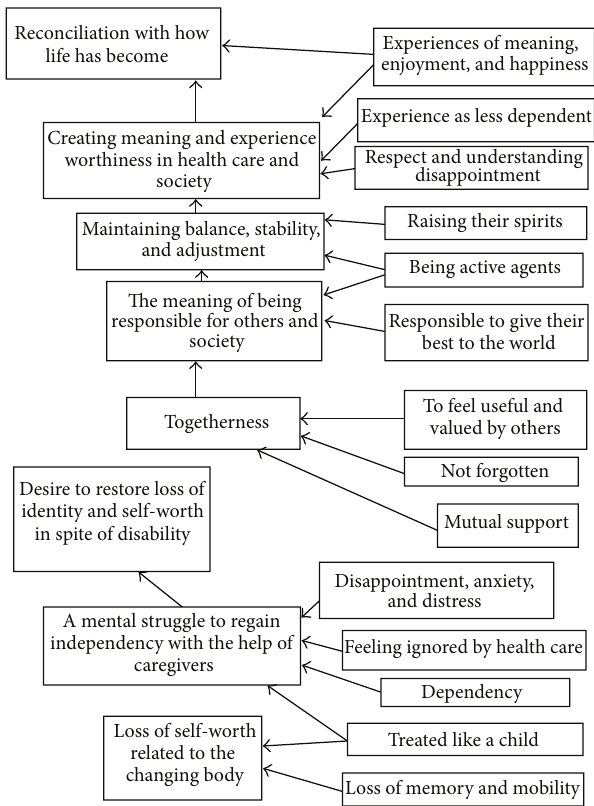
Figure 2: The themes and sub-themes that emerged from the des- criptive